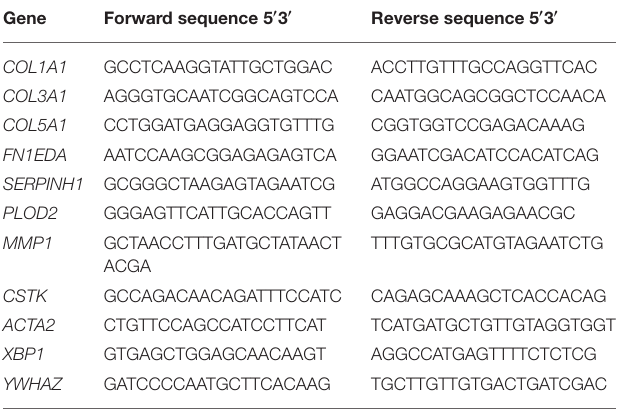
TABLE 1 | Primer sequences used for q-PCR.